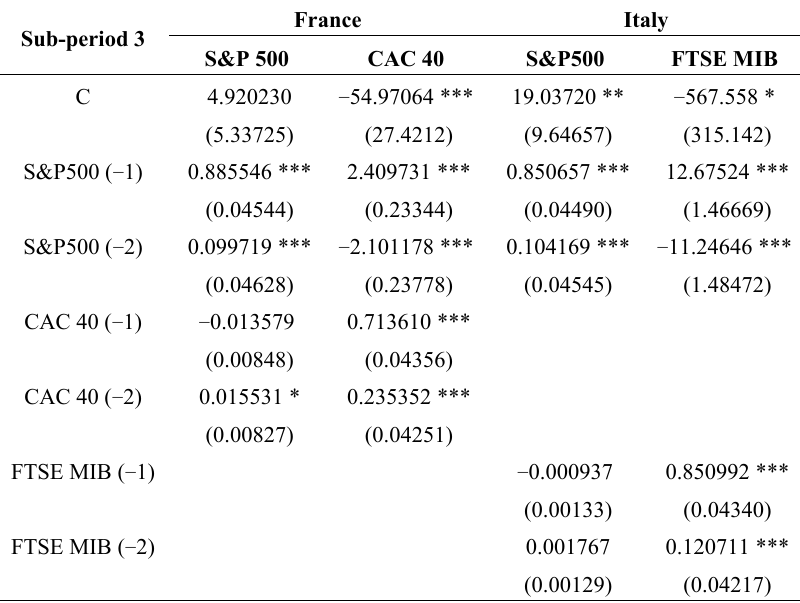
Table A3. Vector Autoregression Estimates for Sub-period